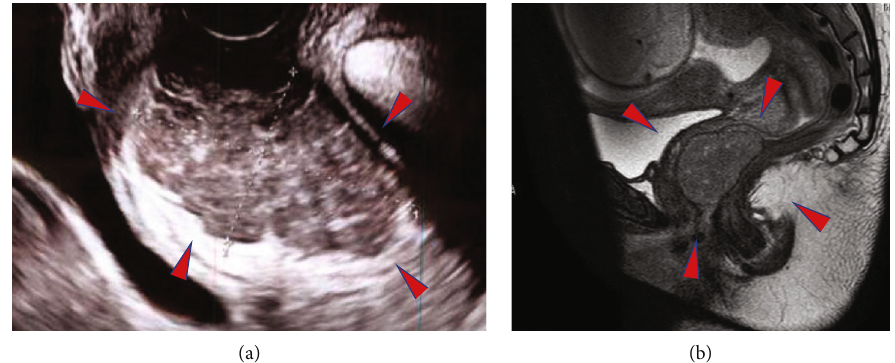
Figure 1: Radiographic images showing the mass. (a) Transvaginal ultrasound: the mass (arrowheads) was 51 : 7 × 32 : 5mm in size. (b) Plain magnetic resonance image of the abdomen and pelvis. An irregular mass (arrowheads) can be seen superior to the